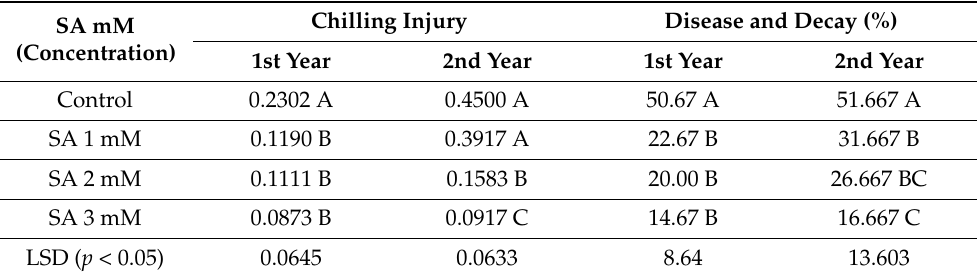
Table 6. Effects of different pre-harvest treatments of SA on the chilling injuries and disease and decay incidences of peach fruits during low-temperature